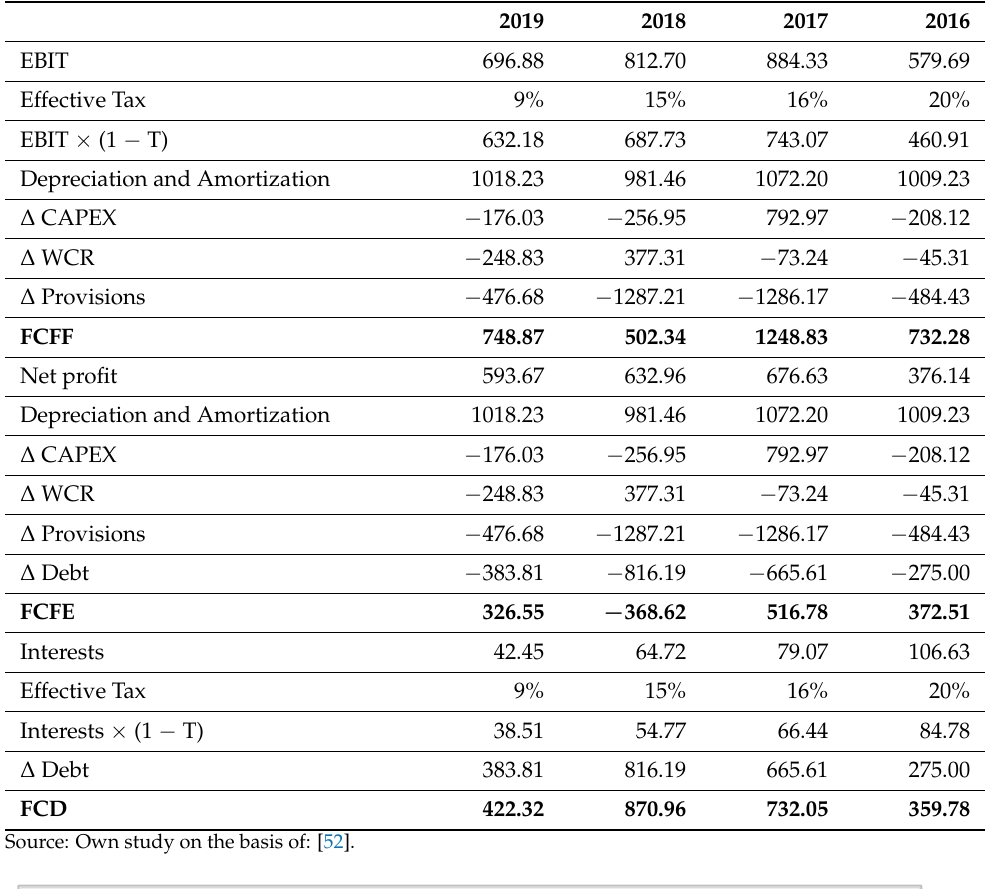
Table 6. Formation of FCFF, FCFE and FCD flows and the components affecting them in Geotermia Podd˛ebice Sp. z o.o. (PLN thousand).